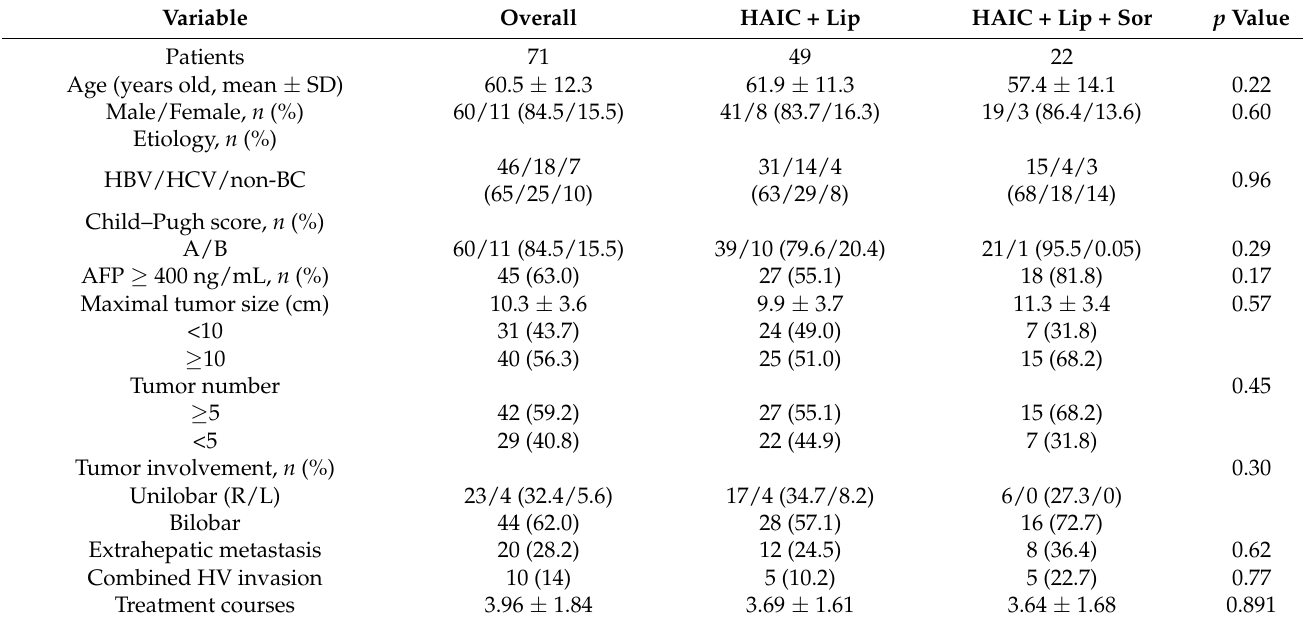
Table 1. Basic demographic data of the 71 Vp4 HCC patients.